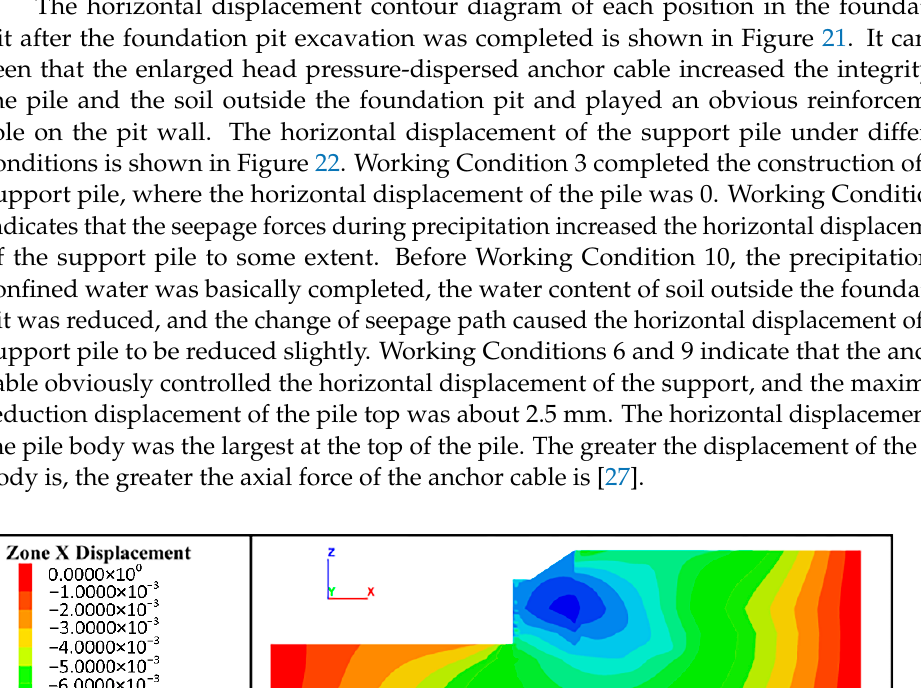
Figure 20. Surface settlement curve around the foundation pit under different working conditions.